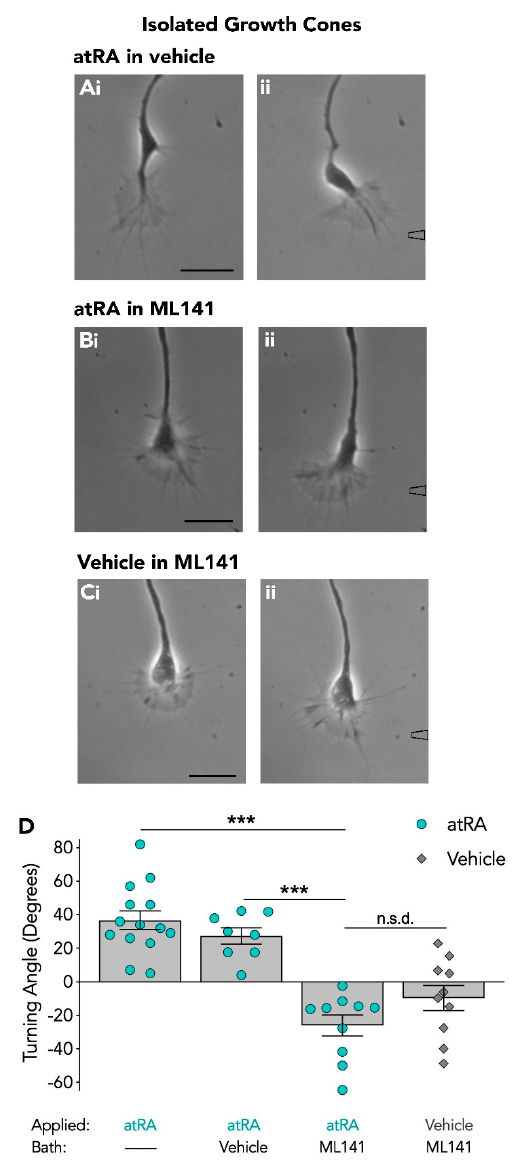
Figure 2. Isolated growth cones fail to turn toward atRA in the presence of the Cdc42 inhibitor. Representative images depicting the turning response of isolated growth cones to atRA in the presence of the vehicle ( Ai – ii ; n = 8; t = 24), and the failure to turn toward atRA in the presence of the Cdc42 inhibitor, ML141 ( Bi – ii ; n = 10; t = 29). The isolated growth cone response to focal application of the vehicle alone in the presence of ML141 is also shown ( Ci – ii ; n = 10; t = 20). The approximate location of the pipette containing either atRA or vehicle is shown to the right of an image ( A – Cii ) and times (t) of growth cone responses are provided in minutes. Scale bars: 15 μ M. ( D ) Graph depicting the mean turning angles of isolated growth cones in each condition. Data were expressed as the mean ± SEM and analyzed using a one-way ANOVA ( F (3,38) = 23.959, p < 0.001) followed by a Tukey Kramer post-hoc test. The mean turning angle of isolated growth cones to atRA is significantly di ff erent in the presence of ML141 compared to in the presence of the vehicle (*** p < 0.001). The mean turning angle produced by atRA in ML141 was not significantly di ff erent (n.s.d.) than the mean turning angle produced by the vehicle in